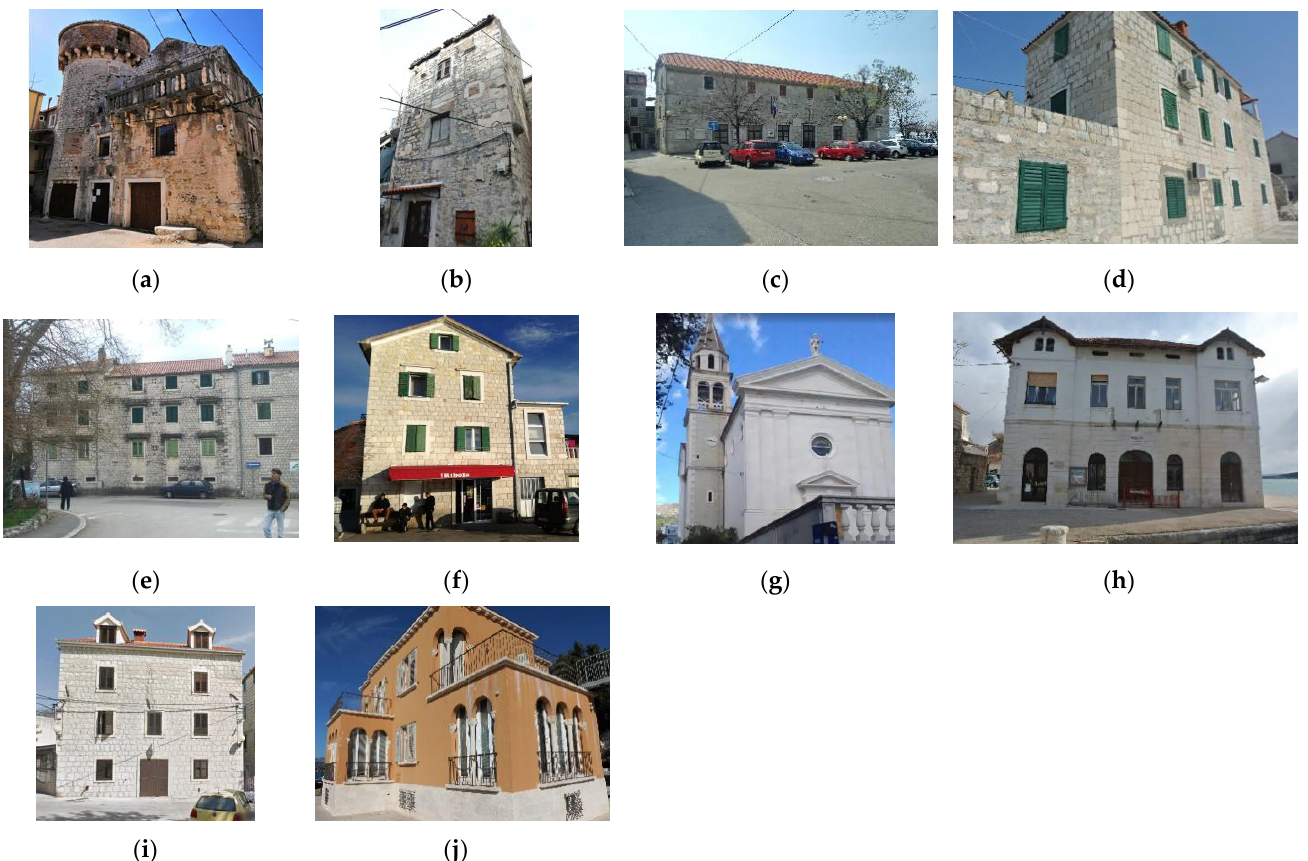
Figure 10. Analyzed buildings in the historical centre: ( a ) Cambi Tower; ( b ) Cumbat Towers; ( c ) Public Library; ( d ) Folk Castle; ( e ) Dudan Palace; ( f ) Perišin house; ( g ) St. Mihovil Church; ( h ) rowing club; ( i ) residential building; ( j ) ballet school.